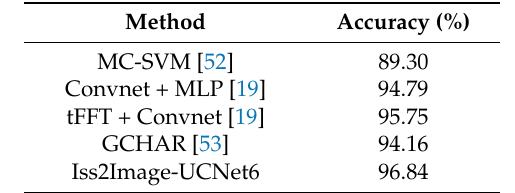
Table 8. Average accuracy comparison between Iss2Image-UCNet6 and existing methods on the UCI-HAR